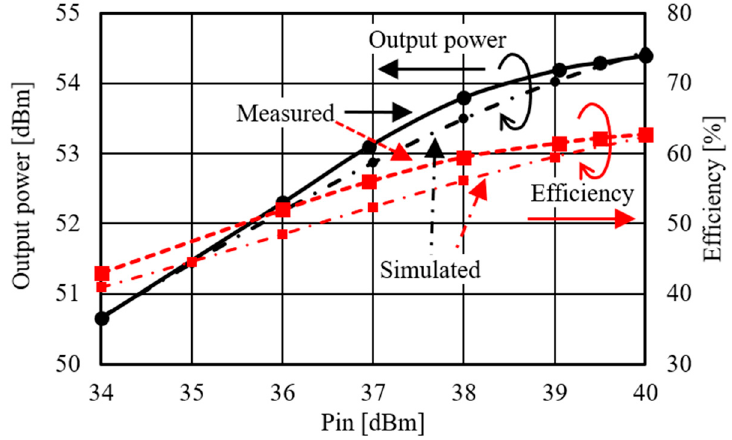
Figure 10. Measured output power and efficiency of the power amplifier.